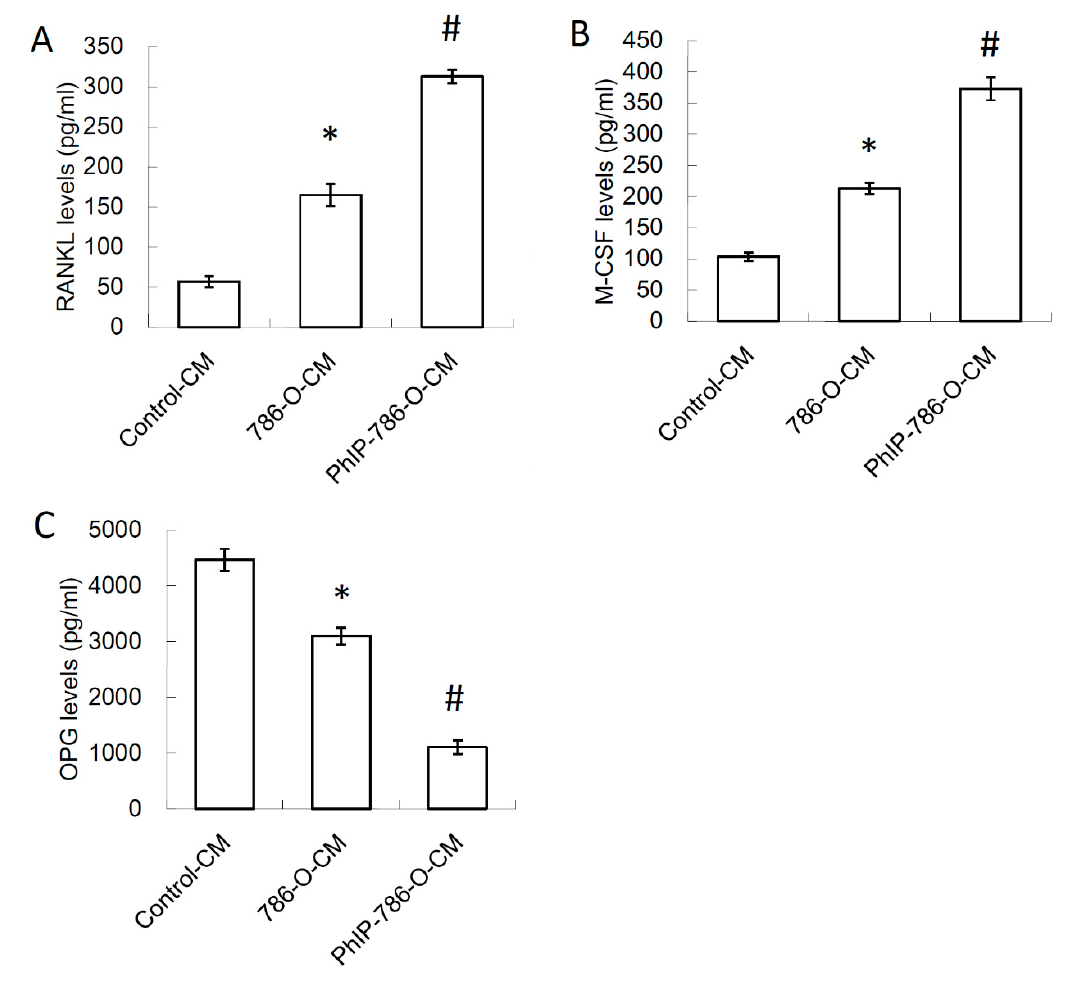
Figure 2. The effect of PhIP-786-O-CM on osteoblast. CM from vehicle control (0.1% DMSO)-treated and 20 μ M PhIP-treated 786-O was defined as 786-O-CM and PhIP-786-O-CM. Fresh medium without culturing CM of 786-O was defined as the control-CM. The human osteoblasts were cultured with various CMs for 24 h. In the supernatants of the osteoblast-cultured media, the levels of ( A ) receptor activator of nuclear factor kappa-B ligand (RANKL) and ( B ) macrophage colony-stimulating factor (M-CSF) osteoprotegerin, and ( C ) osteoprotegerin (OPG) are shown, while bar graphs are shown as the mean ± SD of three independent experiments. * Significant difference with the control-CM treatment, # Significant difference with 786-O-CM treatment, P < 0.05.